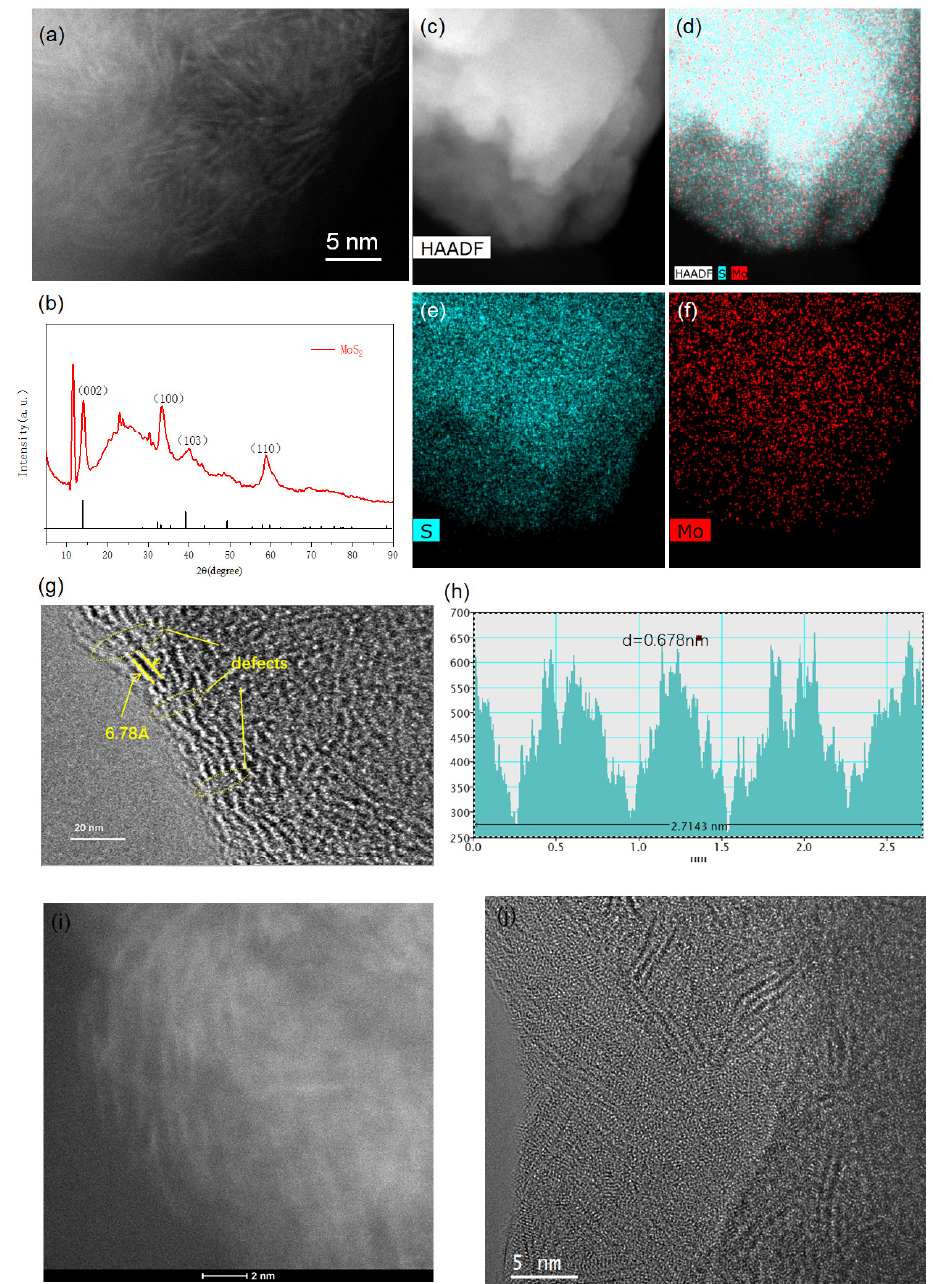
Figure 2. Characterization of the MoS 2 catalyst for the Zn–air battery. ( a ) STEM of the prepared MoS 2 catalyst. ( b – d ) EDS mappings of elementals (Mo and S) of the MoS 2 catalyst. ( e ) XRD pattern of the